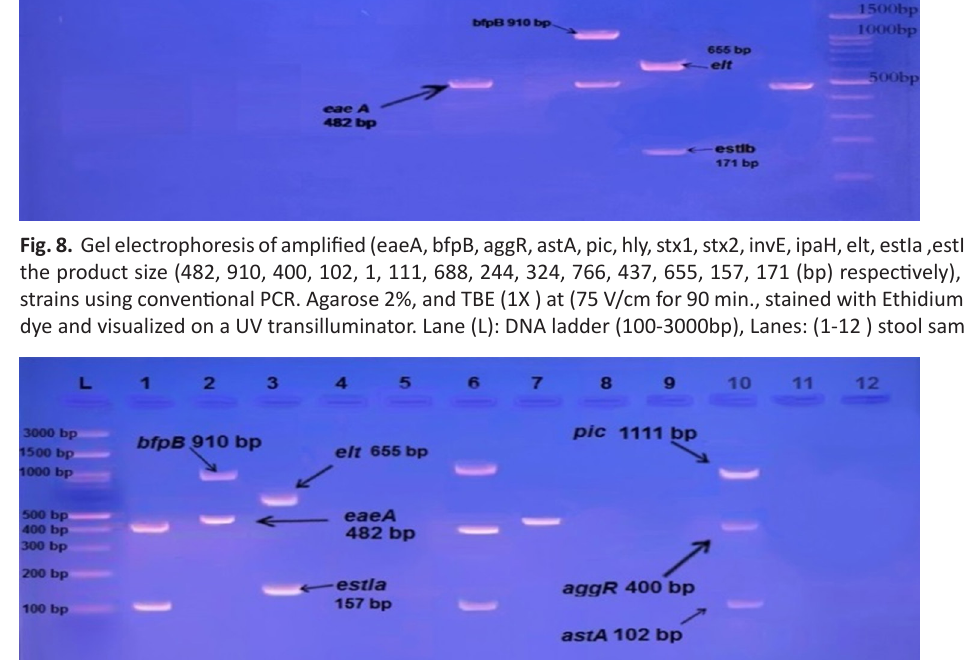
Fig. 9. Gel electrophoresis of amplified ( eaeA, bfpB, aggR, astA, pic, hly, stx1, stx2, invE, ipaH, elt, estIa, estIb ) genes, the product size (482, 910, 400, 102, 1, 111, 688, 244, 324, 766, 437, 655, 157, 171 ( bp ) respectively ), of E. coli strains using conventional PCR. Agarose 2%, and TBE (1X) at (75 V/cm for 90 min., stained with Ethidium bromide dye and visualized on a UV transilluminator. Lane (L): DNA ladder(100-3000 bp), Lanes: (1-12) stool samples.